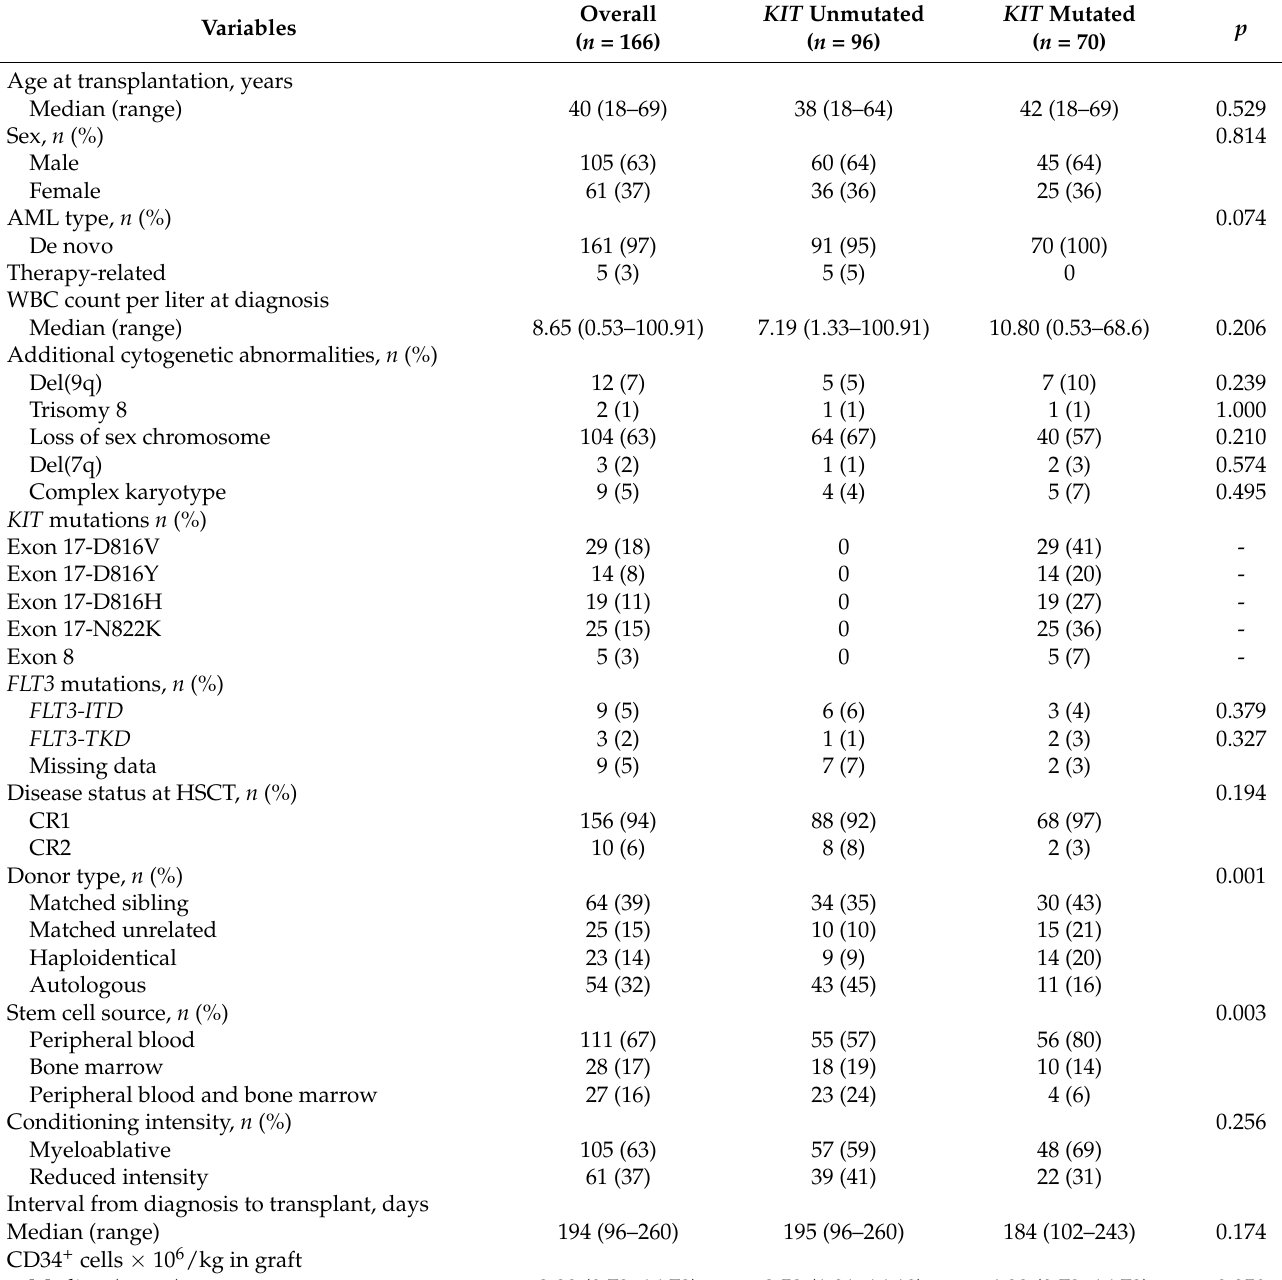
Table 1. Patient-, disease-, and transplant-related characteristics according to KIT